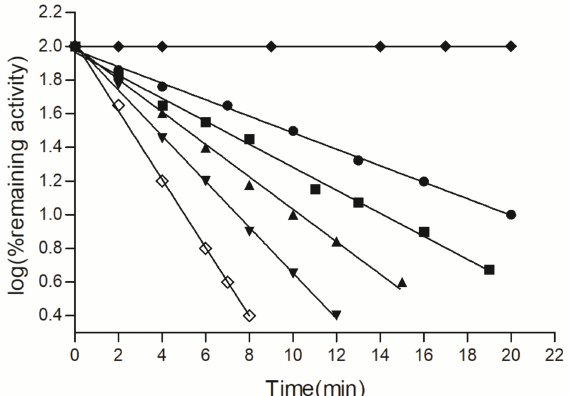
Figure 3. Inactivation of recombinant Cb FDH by AMPS-HDB. Enzyme was incubated in the absence ( (cid:7) ) and in the presence of AMPS-HDB: 0.05 mM ( • ); 0.1 mM ( (cid:4) ); 0.2 mM ( (cid:78) ); 0.3 mM ( (cid:72) ); 0.5 mM ( ♦ ); at pH 8.0 and 25 ◦ C. At the times indicated, aliquots were withdrawn and assayed for enzymatic activity.